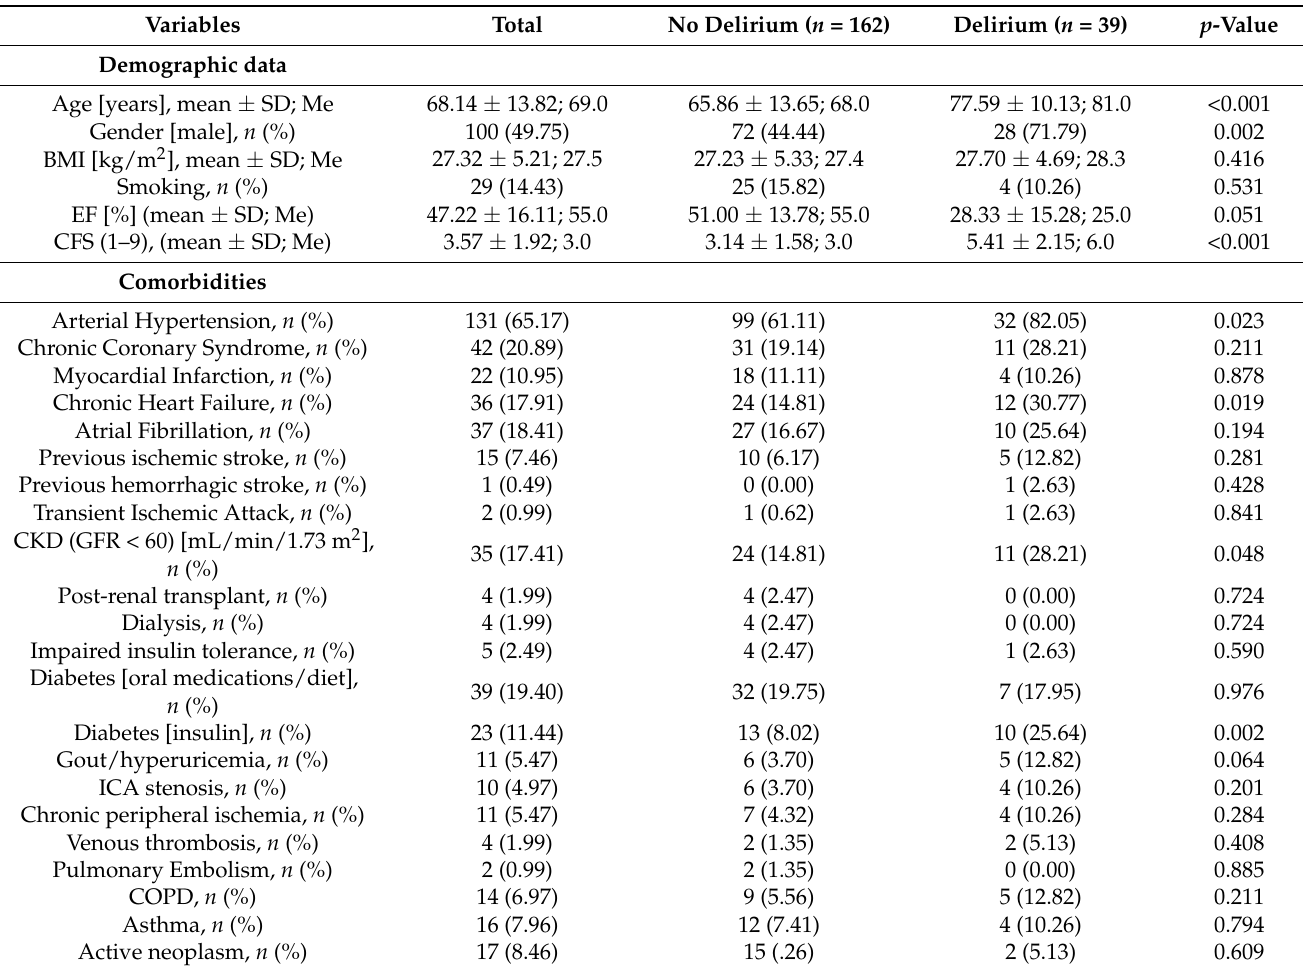
Table 1. Baseline characteristics of patients included in the study.